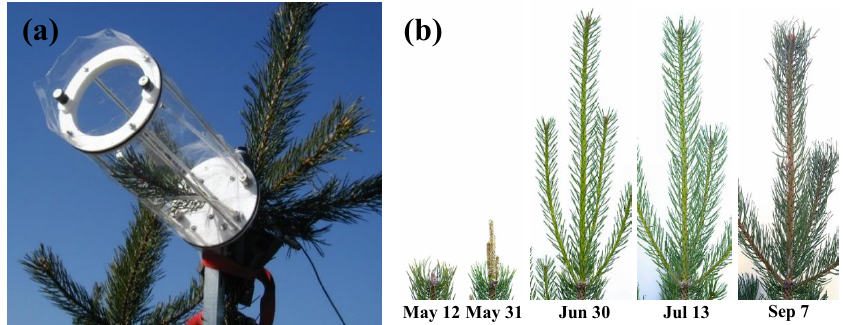
Figure 2. (a) Emission measurements were performed with a transparent shoot chamber, which is here shown open between samplings. (b) Development of a new shoot in Scots pine in 2010. Sampling of new needles started in early July. Photos: Juho Aalto.